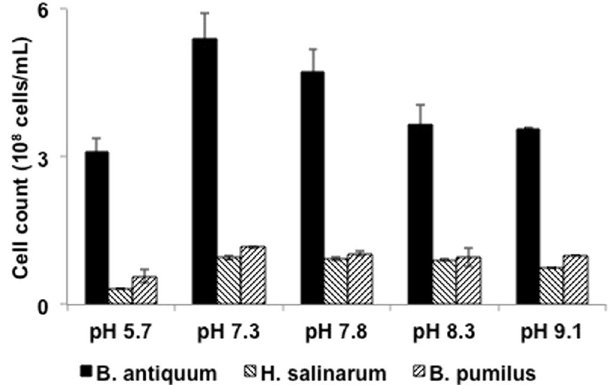
Figure 2. Flow cytometry live cell counts after incubation of the selected bacteria at different pH values.